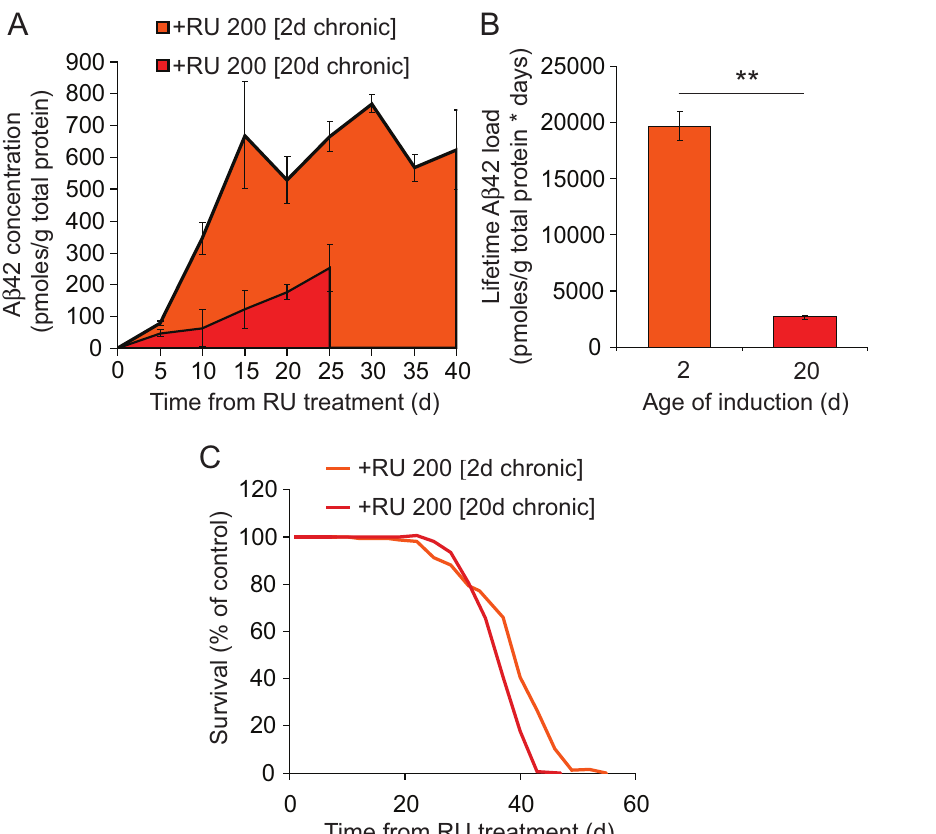
Figure 4. Older flies are more vulnerable to chronically induced Arctic A b 42, despite a lower lifetime exposure to the peptide. (A) UAS-Arctic A b 42/ + ; elavGS/ + females were chronically treated with 200 m M RU486 from 2-days (RU 200 [2d chronic]) and 20-days (RU 200